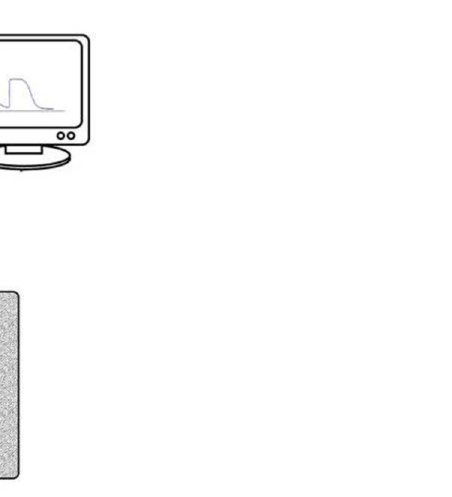
Fig 4. The device used in the work. Schematic diagram of a device for water freezing and ice melting studies.